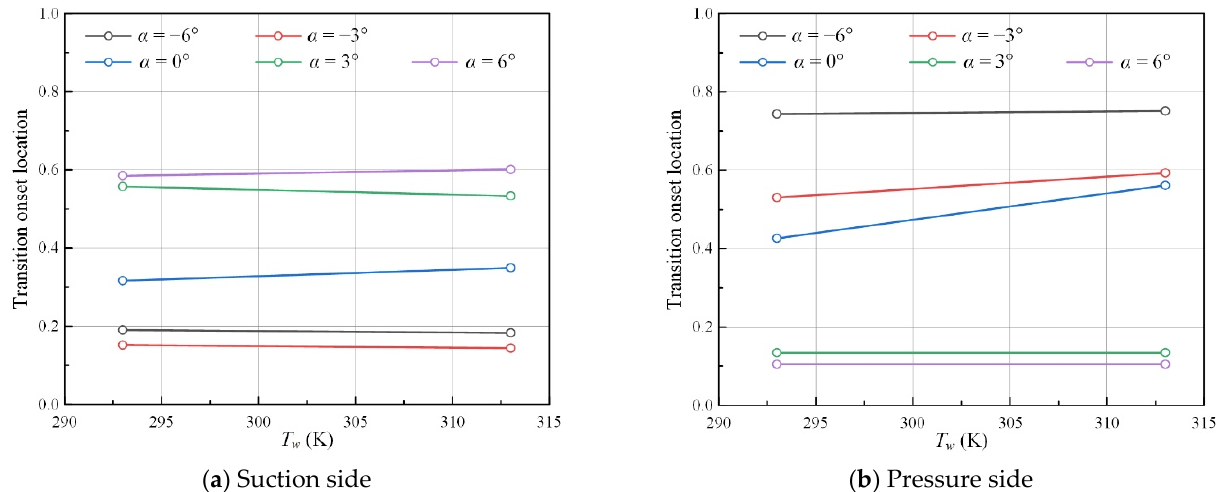
Figure 11. Transition onset locations under various surface temperatures ( ε = 0.5%, Ma = 0.75).